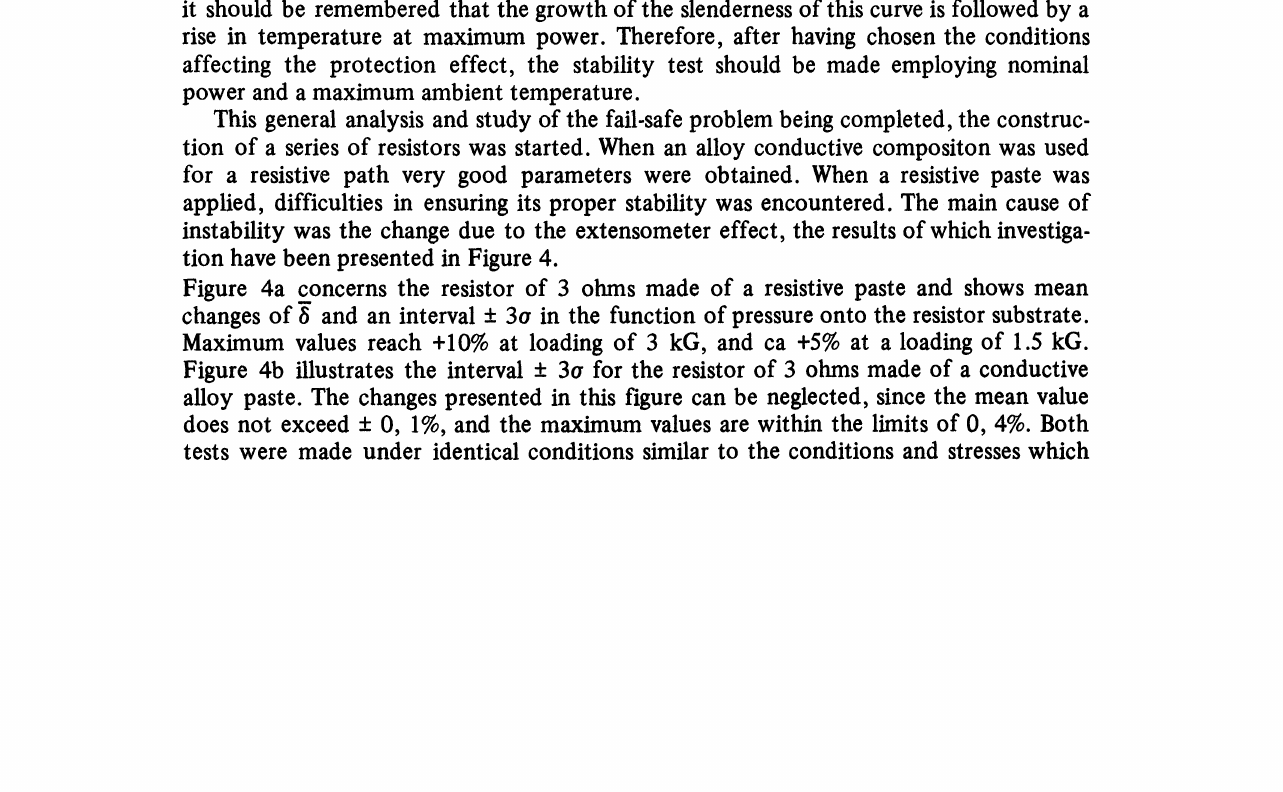
FIGURE 3 Effect of the resistive path shape on the isotherm shape and on hot spot maximum temperature. Figure 3.1 c and Figure 3.2 c present diagrams obtained through thermovision